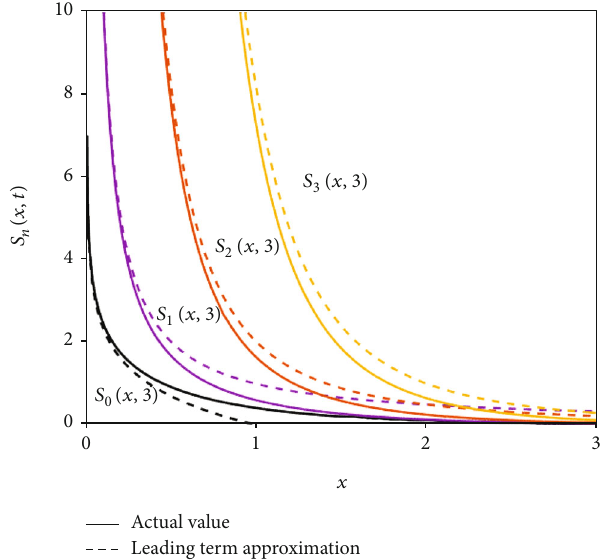
Figure 4: Leading term approximation for x ⟶ 0 +